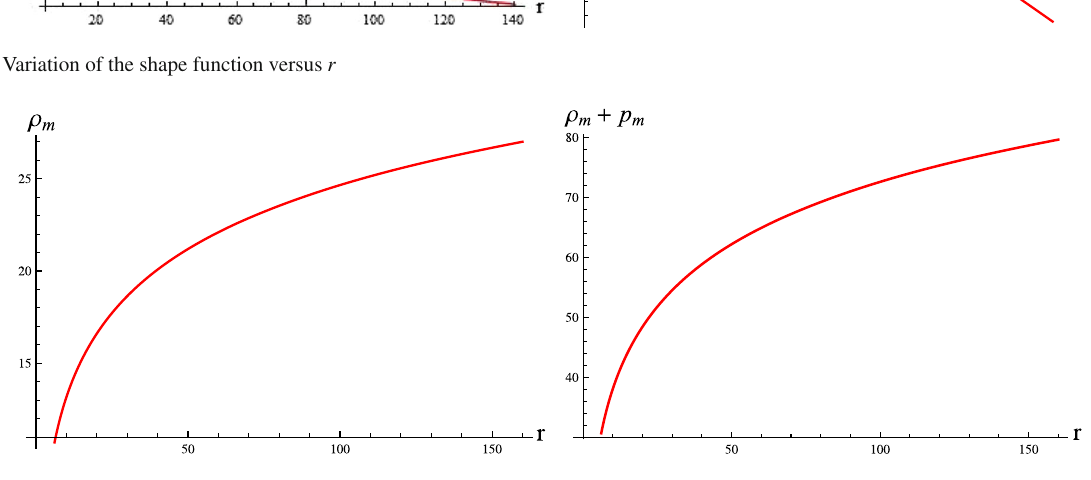
Fig. 7 Evolution of energy bounds versus r for w = −